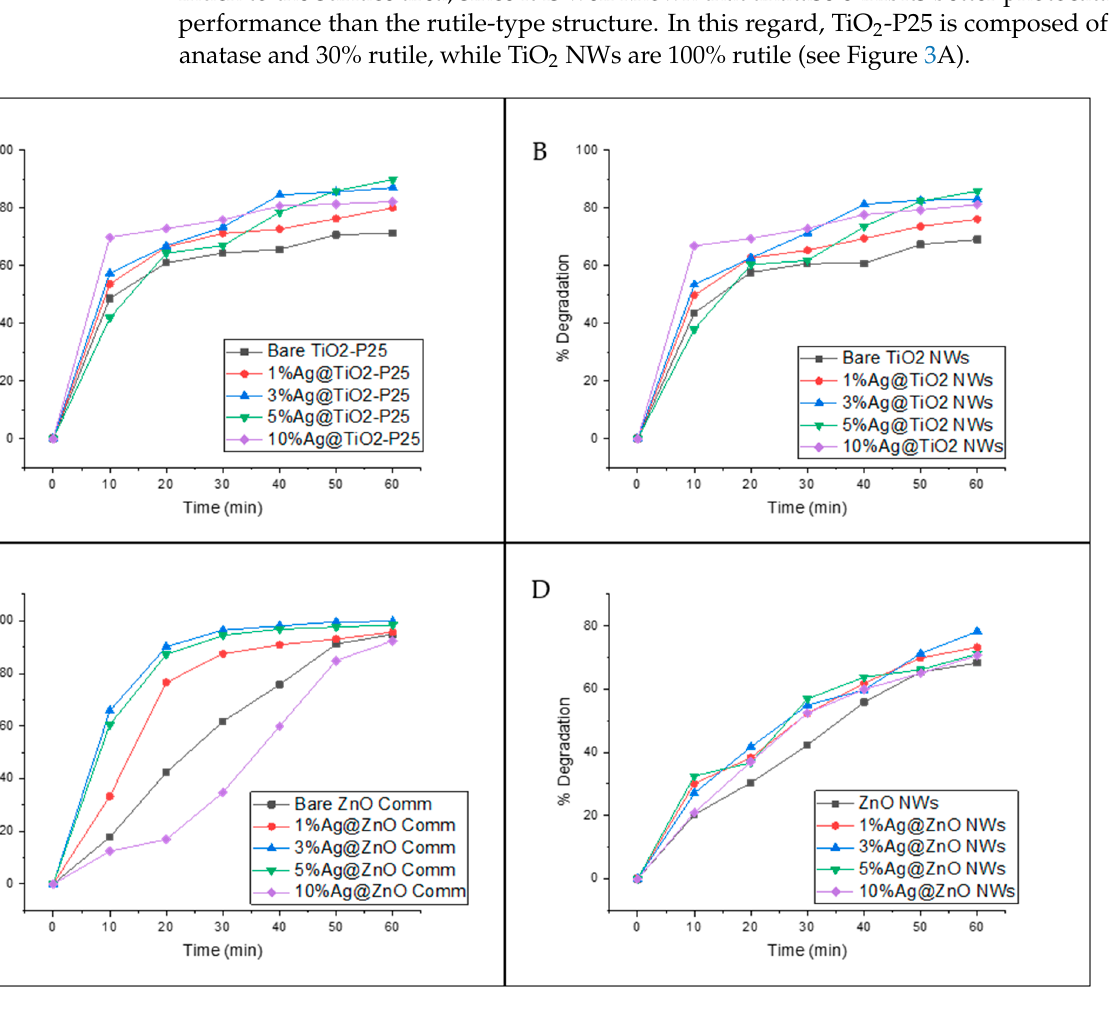
Figure 8. Percentage of degradation of ciprofloxacin using Ag@TiO 2 -P25 ( A ), Ag@TiO 2 NW ( B ), Ag@ZnO commercial ( C ), and Ag@ZnO NW ( D ) catalysts.